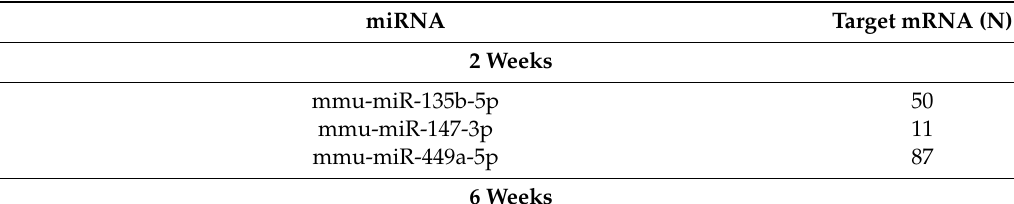
Table 3. miRNAs and numbers of corresponding targeted mRNAs after inhalation of CuO NPs for individual exposure